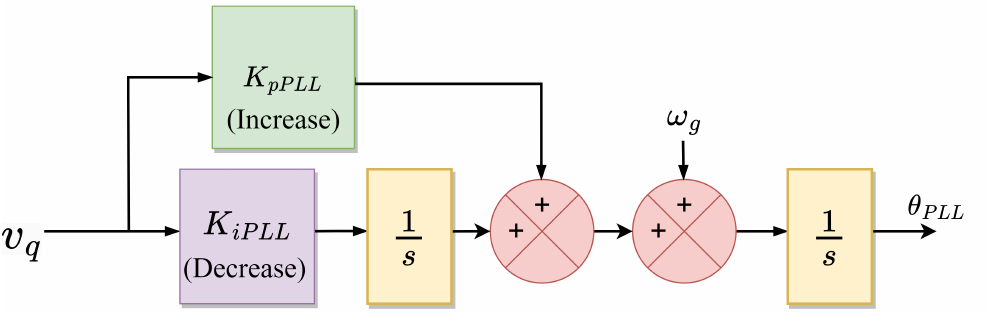
Figure 15. Approach 2